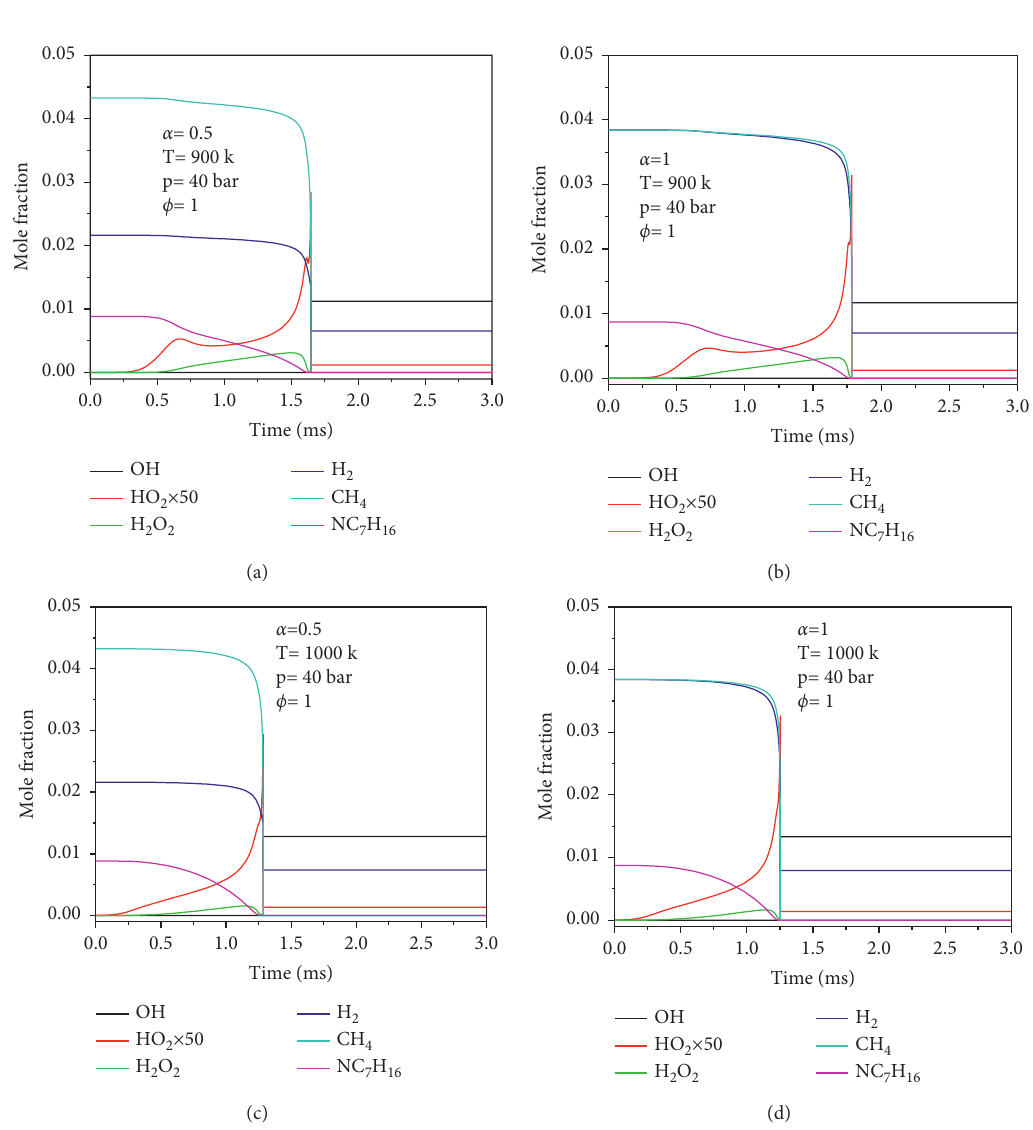
� 4.545 × 10 − 2 , p � 40 bar, and 2 / n -heptane mixtures at β